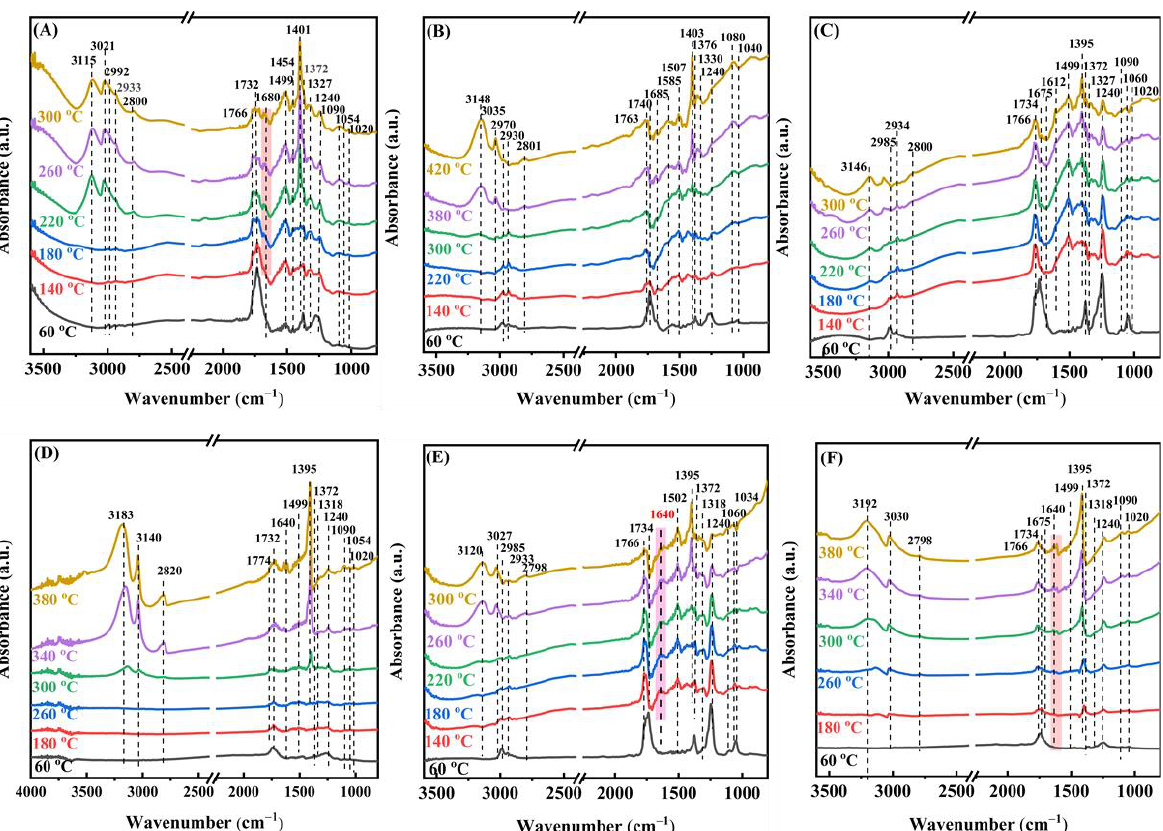
Figure 10. In situ DRIFTS spectra of ( A ) 0.33Pd/TiO 2 , ( B ) 0.36Au/TiO 2 , ( C , E ) 0.34AuPd 2.09 /TiO 2 , and ( D , F ) TiO 2 during ( A – D ) 1000 ppm ethyl acetate oxidation and ( E , F ) (1000 ppm ethyl acetate + 50 ppm SO 2 ) oxidation at different temperatures. 50 ppm SO 2 ) oxidation at different